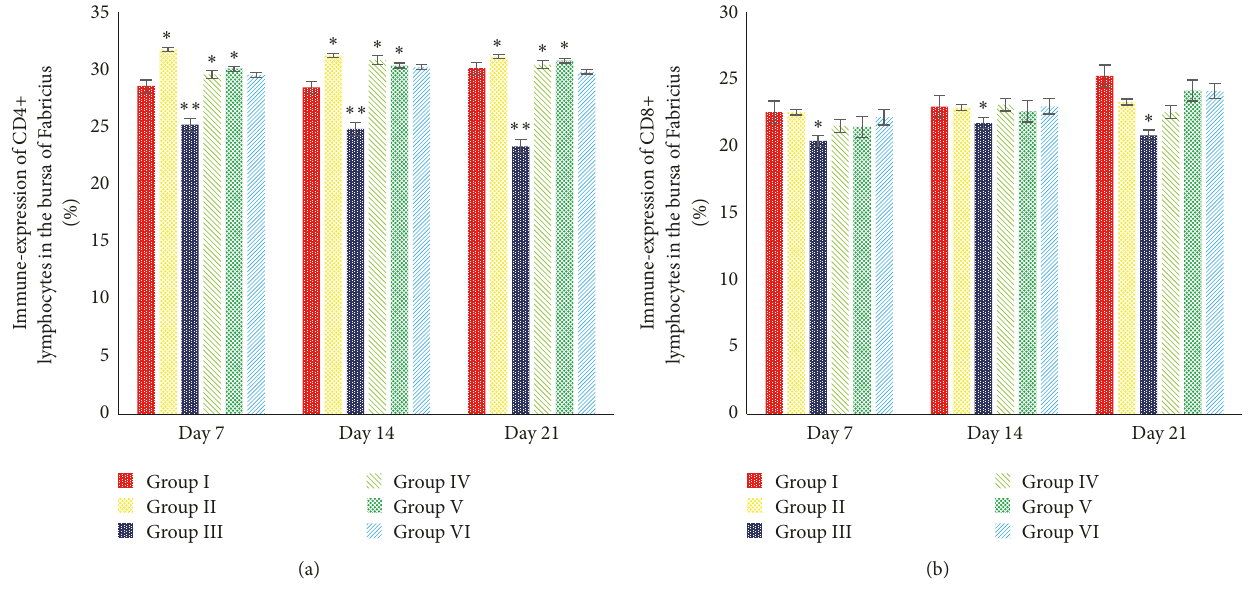
Figure 7: Effects of 5% SAP on the immune-expression of CD4+ (a) and CD8+ (b) lymphocytes in the BF of broiler chickens fed a diet naturally contaminated with AF at 7, 14, and 21 days of age. ∗ / ∗∗ The different superscript showed significantly different values ( P < 0.05).